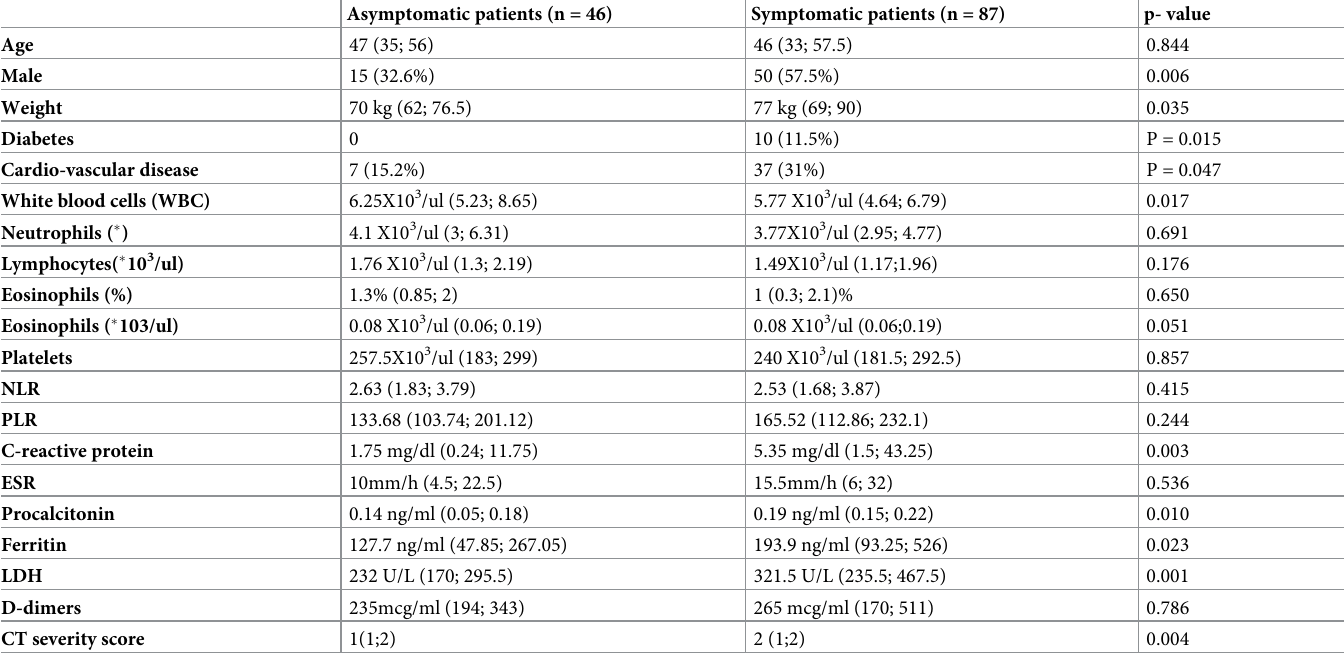
Table 3. Clinical characteristics and blood tests/inflammatory markers in asymptomatic and symptomatic